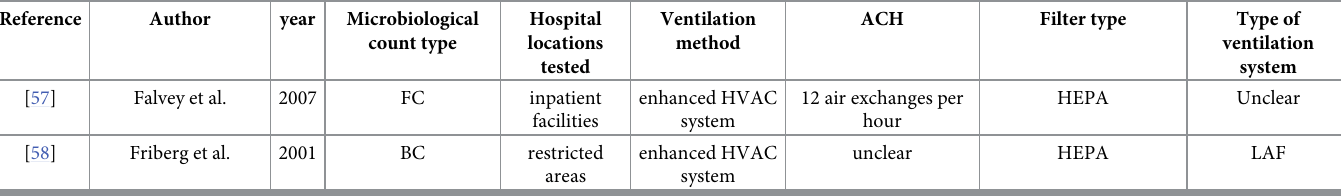
m 3 ; fungal count: 5.46 ± 2.77 CFU/m 3 ) were significantly lower than those in TAF conditions (bacterial count: 36.13 ± 38.29 CFU/m 3 ; fungal count: 0.09 ± 0.07 CFU/m 3 ), while the